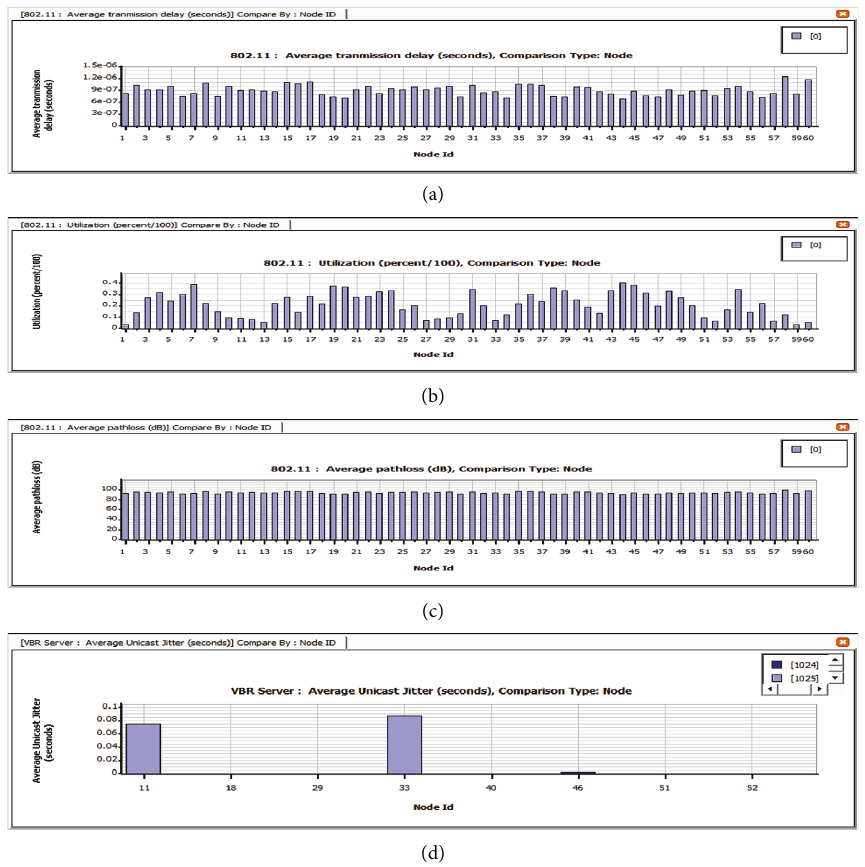
Figure 23: (a) Average transmission delay of OLSR for VBR deployment. (b) Percentage of utilization of OLSR for VBR deployment. (c) Average pathloss of OLSR for VBR deployment. (d) Average jitter of OLSR for VBR